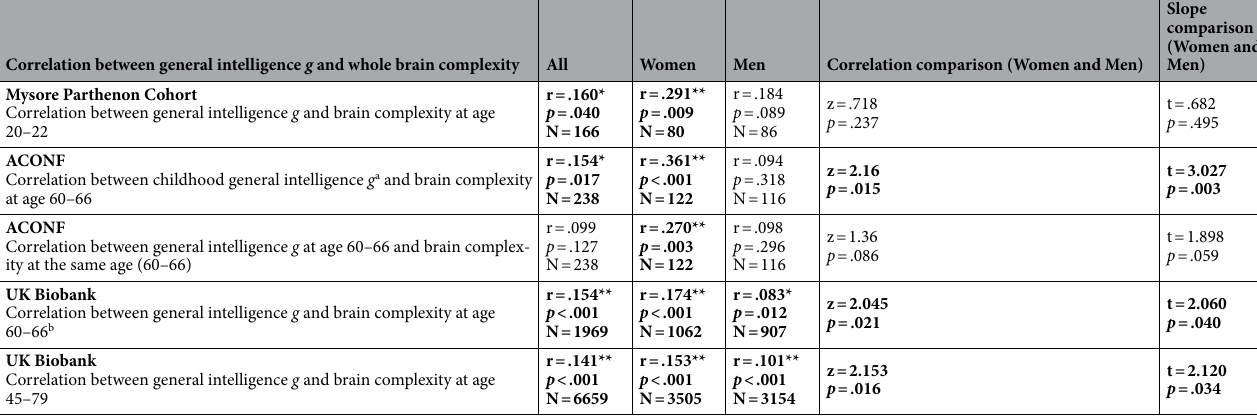
Table 5. Pearson correlations between whole brain complexity and general intelligence g and correlation comparison between sexes; where r is the correlation coefficient; **correlation is significant at the .01 level (2-tailed), *correlation is significant at .05 level (2-tailed), the probability p < .05 is uncorrected; test statistic z for correlation comparison (First transformed the r to Z using the Fisher Z transformations so that they were normally distributed and then applied a Z test where the differences in the Z measured was divided by the standard error. A Z score of greater than ± 1.96 was considered significant), and t statistic for the slope difference. The significant values are shown in bold. a Childhood general intelligence g data are not contemporaneous with MRI acquisition as for the rest of data. b The UK Biobank group 60–66 y was